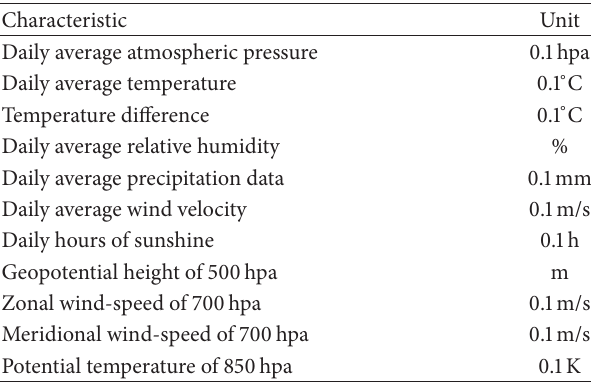
Table 1: The features for sand-dust storm